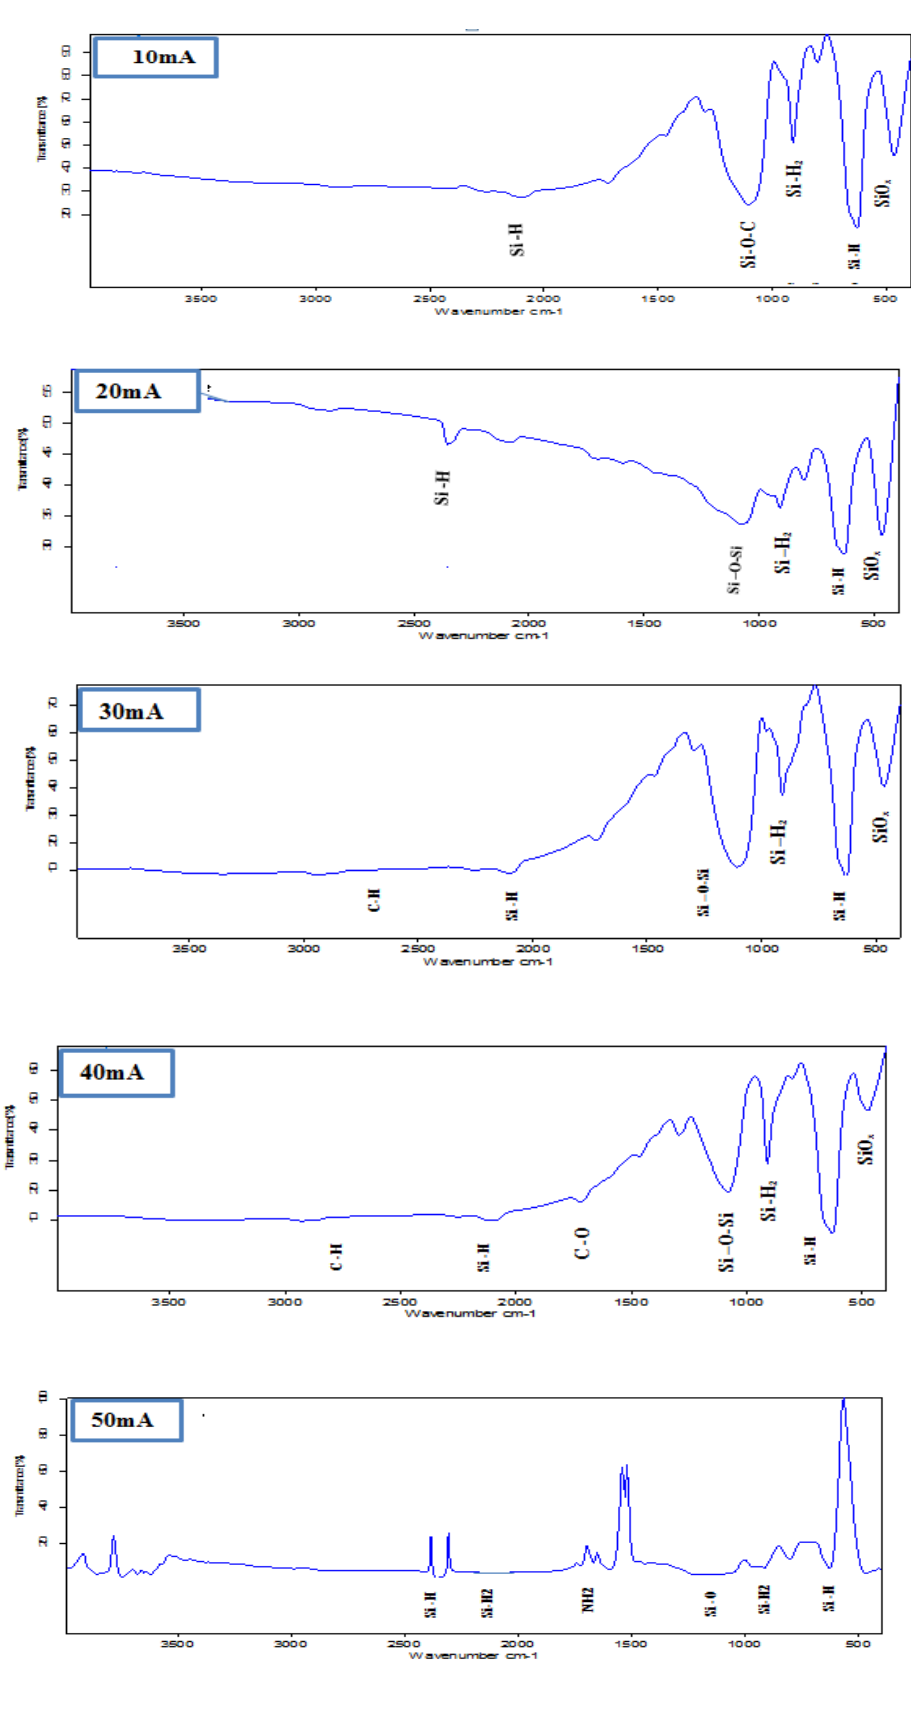
Fig. 6: IR transmittance spectrum of a PS layer at etching current density of 10, 20, 30, 40 and 50